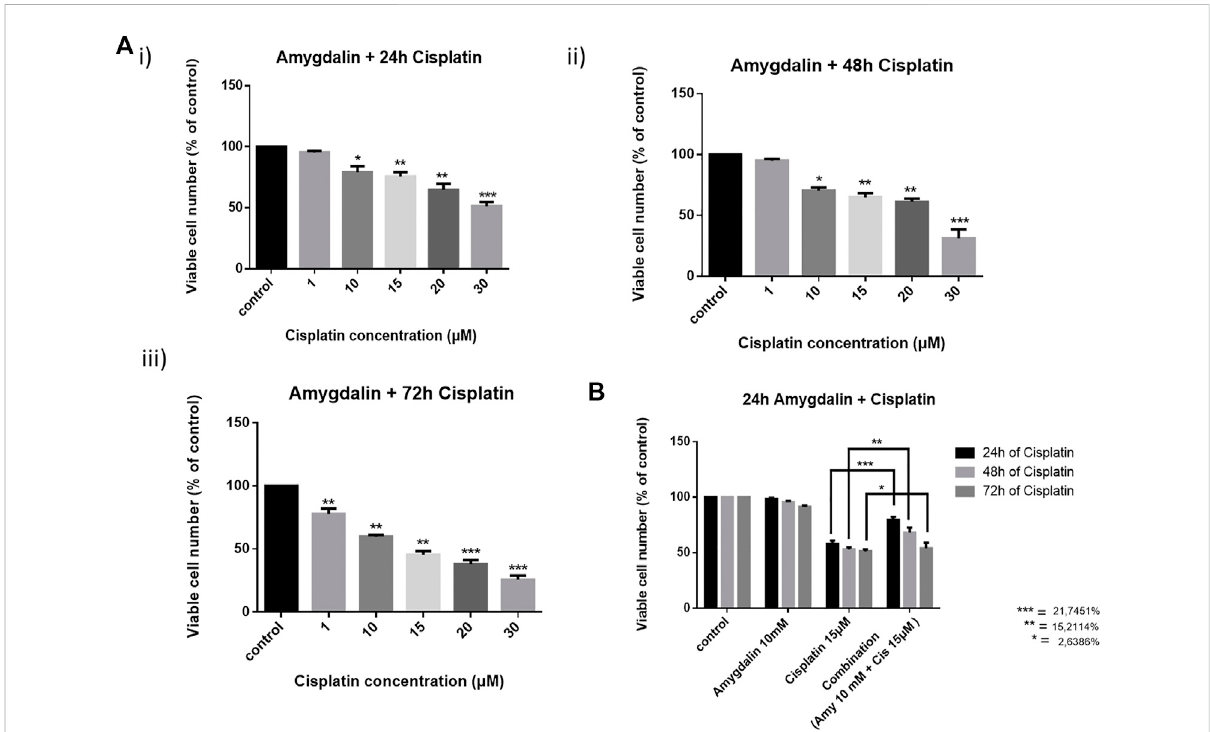
FIGURE 2 Effectofcisplatinaloneandincombinationwithamygdalininnormalbreastcells,MCF12F.Cellswerepre-treatedwith10 mMofamygdalinand then cisplatin (1, 10, 15, 20, and 30 μ M) was added for (A) i) 24 h, ii) 48 h, and iii) 72 h. The MTT assay was applied to measure viability of cells under these conditions. (B) Amygdalin (10 mM) reduces the cytotoxicity of cisplatin (15 μ M) and increases survival at all time points with the pick at 48 h of totaltreatment. Theresults represent themean±SEM ofthreedifferentreplicates andarerepresentativeofatleastthree differentexperiments [* (0.05) < ** (0.01) <